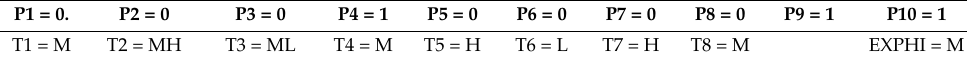
Table 5. Privacy and trust ratings and EXPHI value